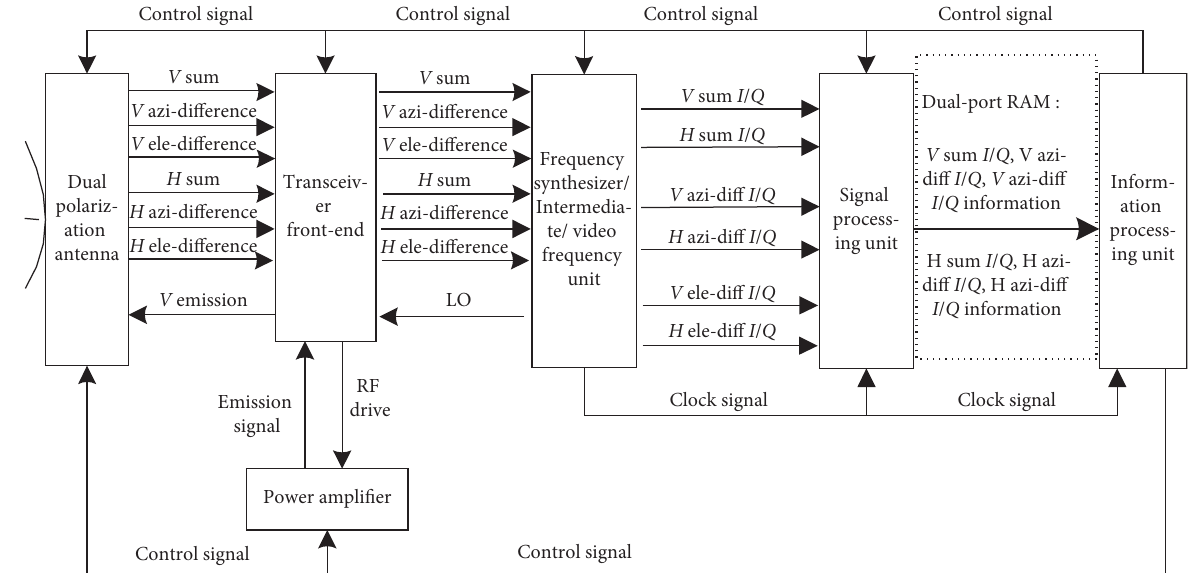
Figure 2: Principle diagram of dual polarization